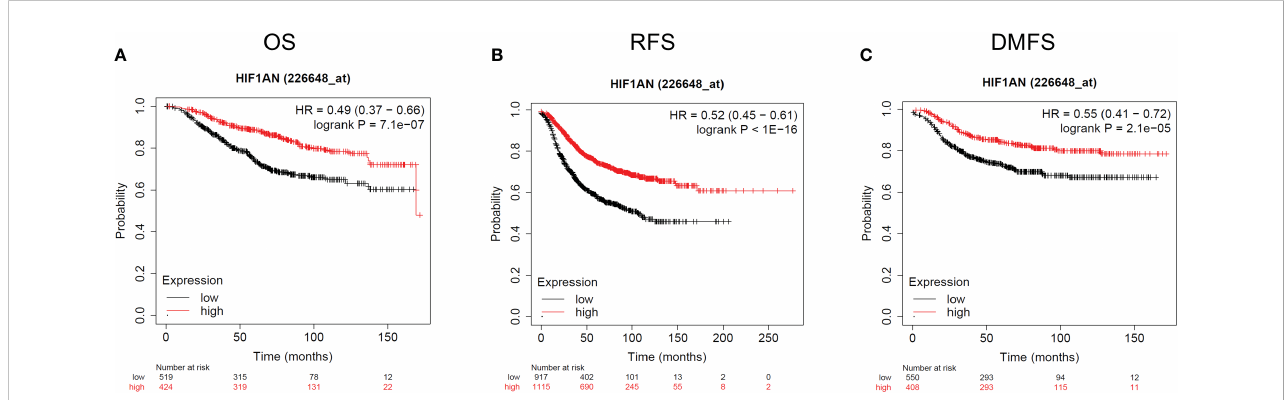
FIGURE 3 Kaplan-Meier survival curves comparing the elevated and reduced expression of HIF1AN in BC. Survival curves of OS (A) , RFS (B) , and DMFS (C) . OS, overall survival; RFS, recurrence-free survival, DMFS, distant metastasis-free survival.